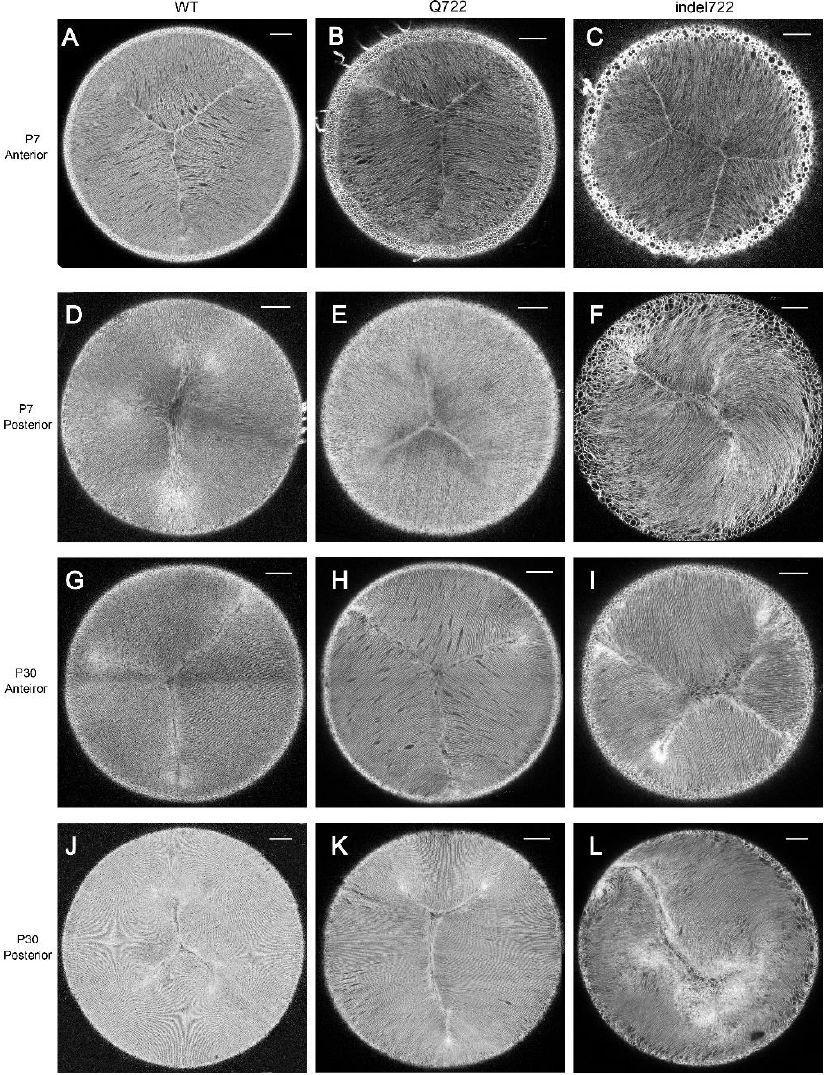
Figure 4. Whole-mount imaging of Y-suture formation in Epha2 -mutant lenses. ( A – C , G – I ) Represen- tative anterior suture images of wild type ( A , G ), Epha2-Q722 ( B , H ), and Epha2 -indel722 ( C , I ) lenses at P7 ( A – C ) and P30 ( G – I ). ( D – F , J – L ) Representative posterior suture images of wild-type ( D , J ), Epha2-Q722 ( E , K ), and Epha2 -indel722 ( F , L ) lenses at P7 ( D – F ) and P30 ( J – L ). Image depth from lens surface: 100–150 µ m ( A – L ). Scale bar: 100 µ